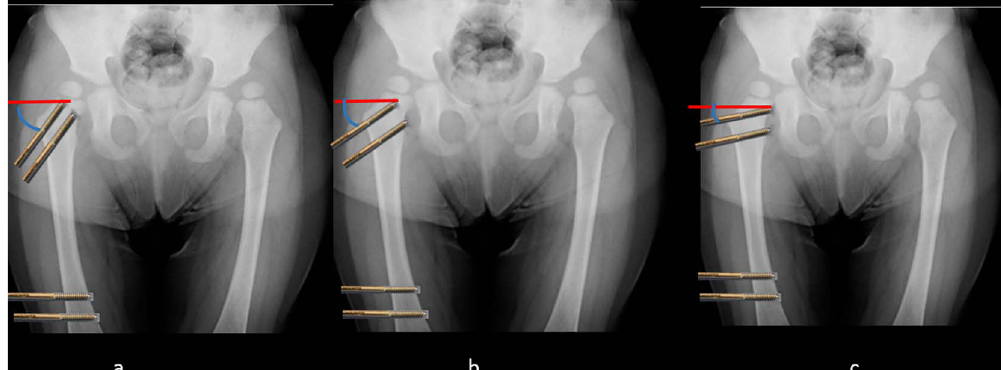
Figure 3. The amount of varisation: The amount of diversion angle between proximal and distal pins (Cobb angle) equals the amount of varisation. The more converted angle, the more varisation. a > b >